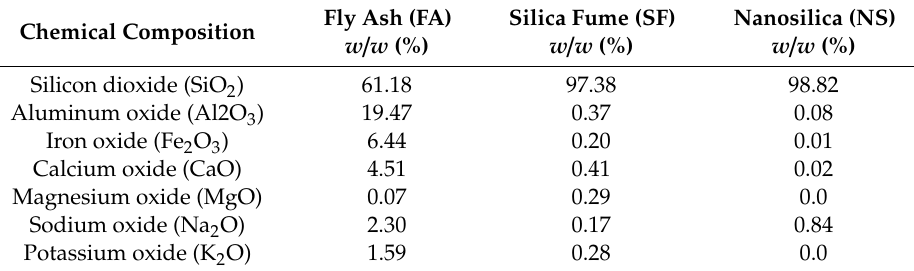
Table 2. The Chemical compositions of pozzolanic materials.